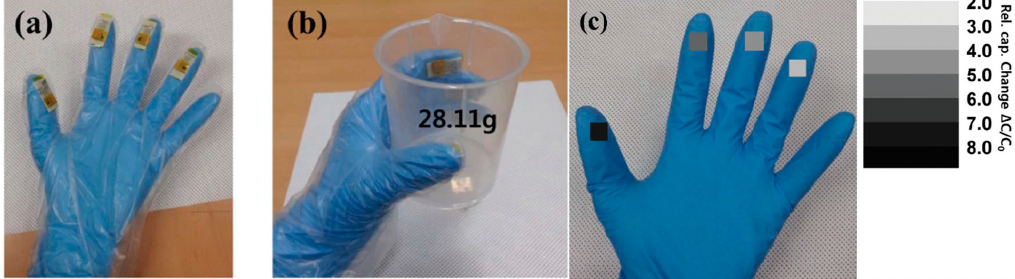
Figure 4. Fingertip grip pressure-sensing device (redrawn from [65]). ( a ) Fingertip grip pressure sensors attached to four fingertips; ( b , c ) Holding a plastic beaker with four fingertips; the resultant relative capacitance changes are indicated.